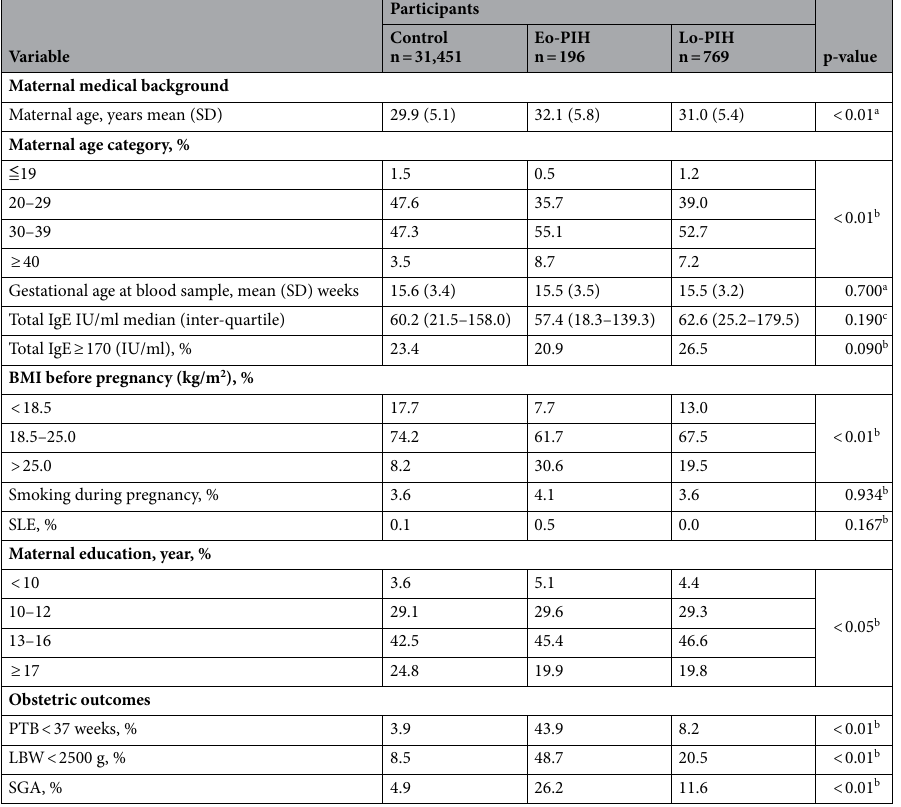
Table 2. Maternal background and obstetric outcomes for Eo-PIH and Lo-PIH. Eo early-onset, Lo late-onset, HDP hypertensive disorders of pregnancy, SD standard deviation, IgE immunoglobulin E, BMI body mass